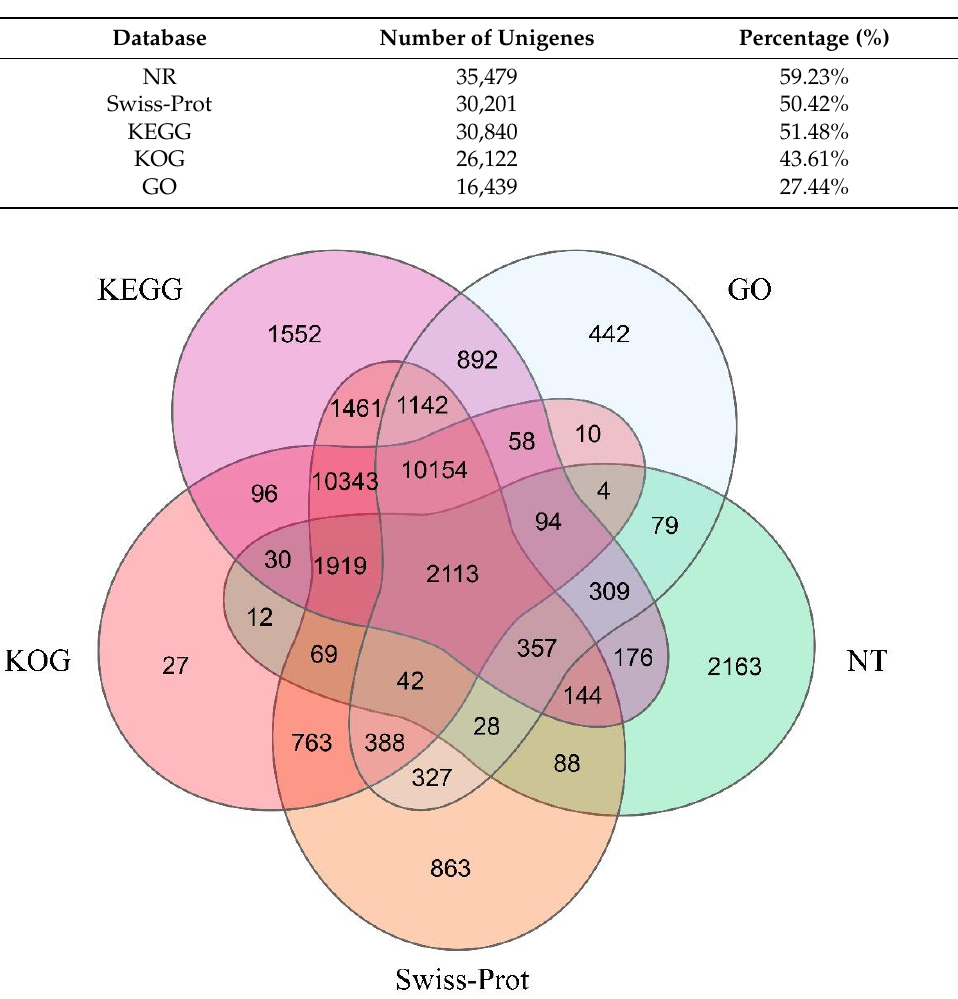
Table 1. Summary of unigenes annotations.